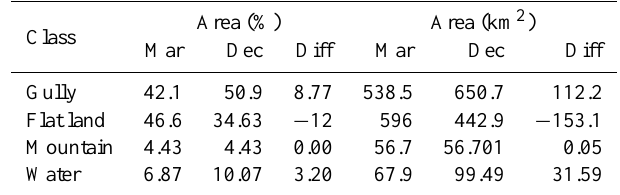
Table 7. Local change of erosion area as indicated by the differ- ence (diff) in area percentage (%) or in km 2 between March and December 2006 for the four land cover classes.